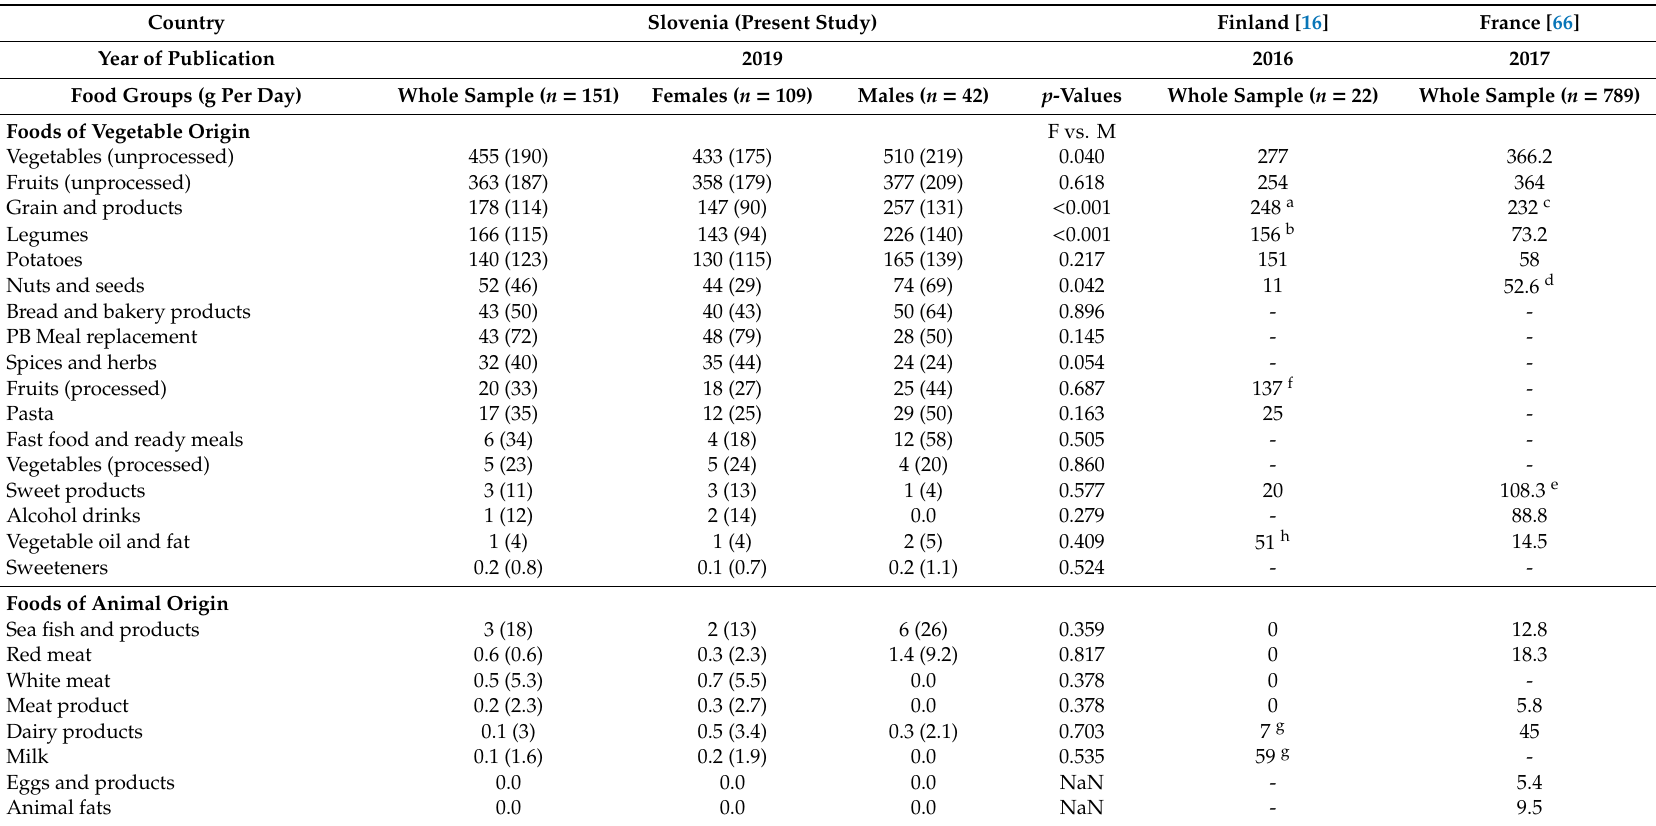
Table 4. Intake of food groups among participants in WFPB lifestyle program, and comparison with two studies on PB dieters. Country Slovenia (Present